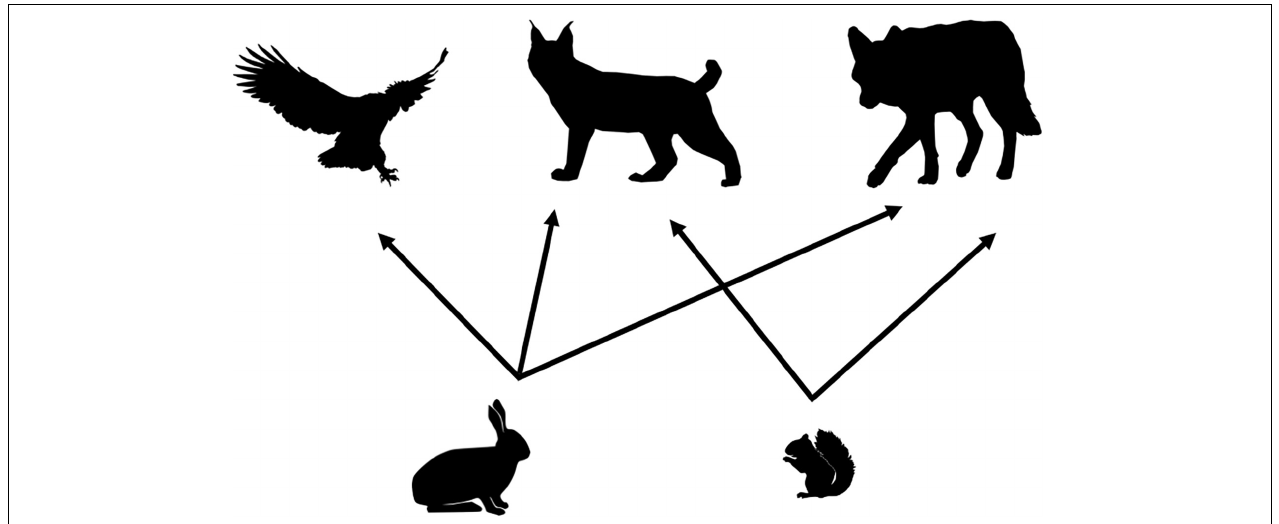
FIGURE 2 | Simplified food web for the Kluane vertebrate system, Yukon, Canada focused around the cyclic dynamics of snowshoe hares. Hares are preyed on by lynx, owls, and coyotes. Red squirrels are an alternate prey item for both lynx and coyotes.